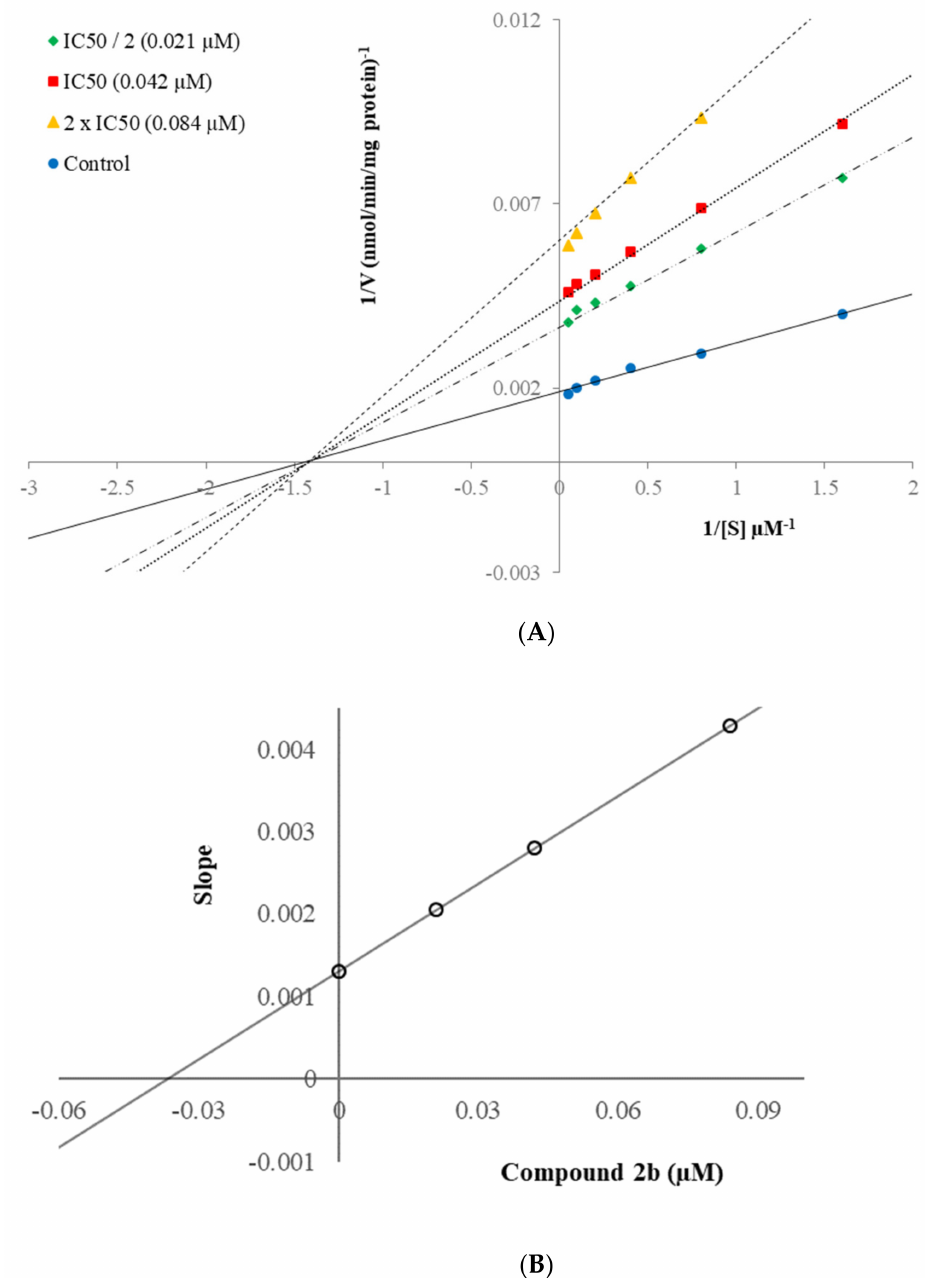
Figure 4. ( A ) Lineweaver–Burk plots for the inhibition of hMAO-B by compound 2b . [S], substrate concentration ( µ M); V, reaction velocity (nmol/min/mg protein). Inhibitor concentrations are shown at the left; ( B ) Secondary plot for the calculation of the steady-state inhibition constant (K i ) of compound 2b . K i was calculated as 0.035 µ